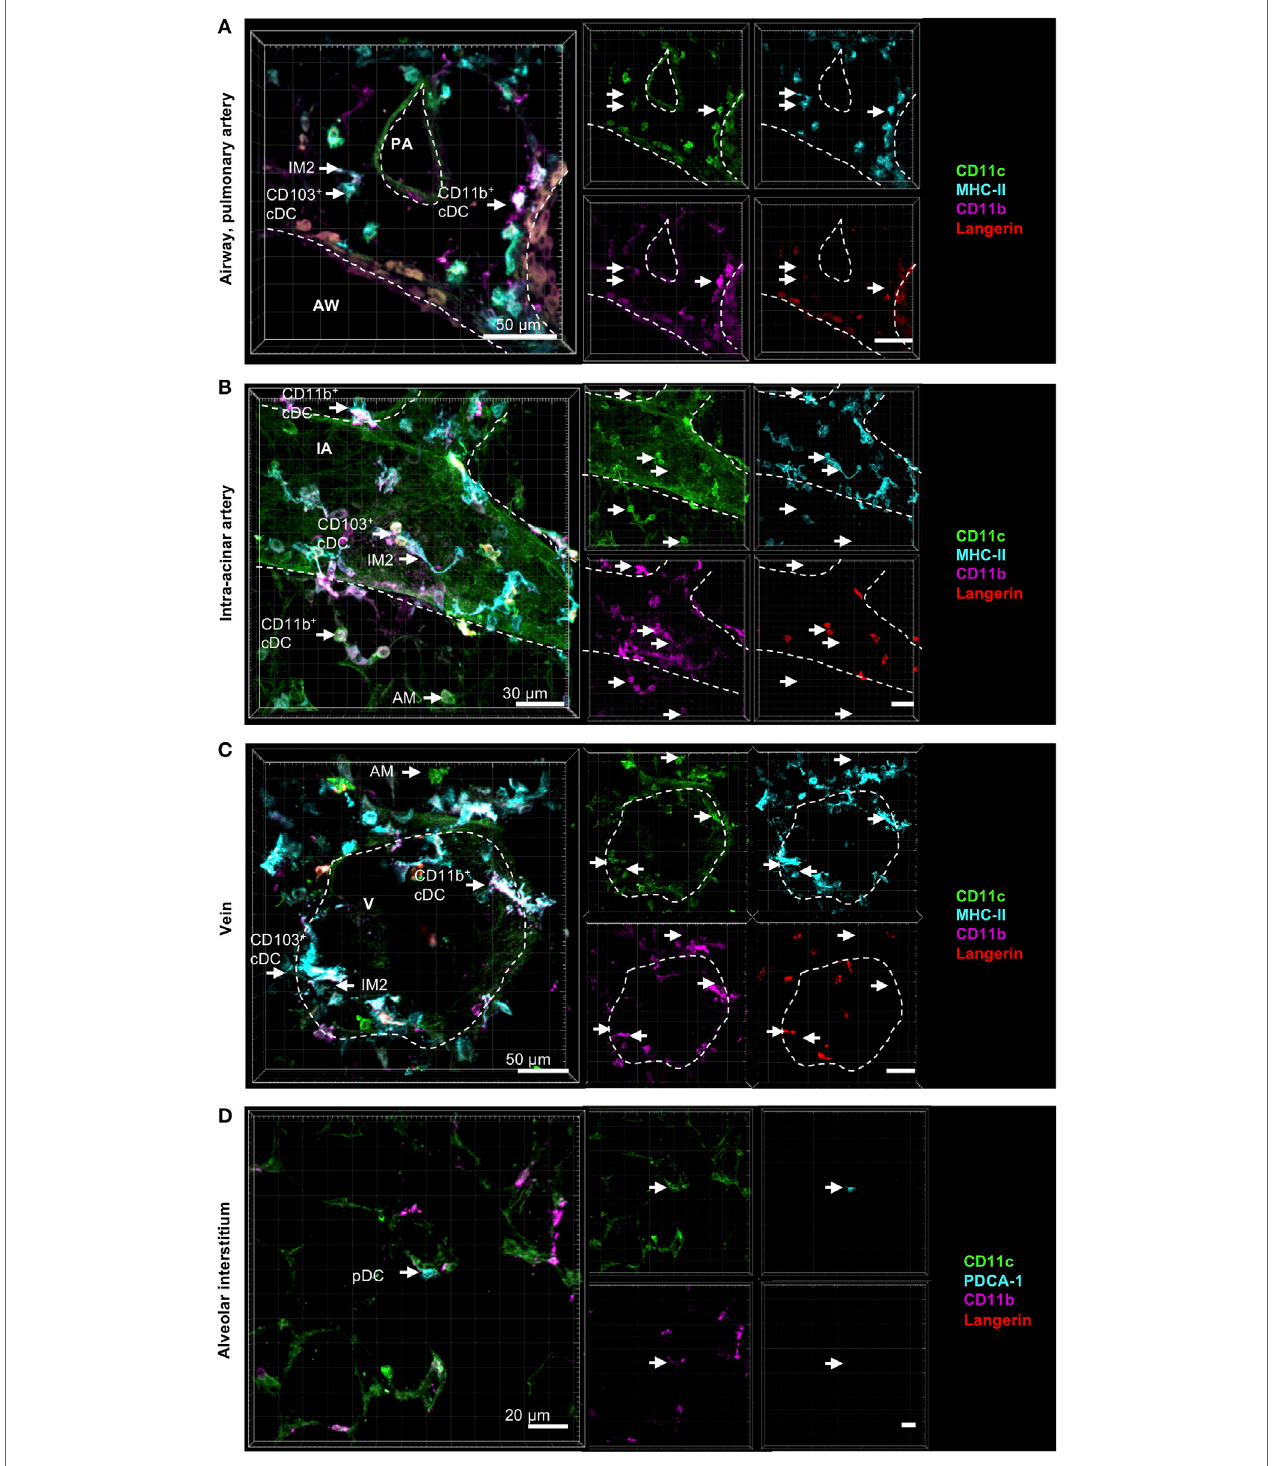
FigUre 3 | Localization of pulmonary dendritic cell (DC) and macrophage subsets by immunohistochemistry (IHC). Precision cut lung slices (PCLS) (300 µm) from naive C57BL/6 mice were generated and stained with anti-CD11c (green), anti-MHC-II or mPDCA-1 (turquois), anti-CD11b (purple), and anti-Langerin (red) ABs. Stained slices were evaluated with confocal microscopy. Conventional DCs (cDCs) and interstitial macrophages (IMs) were localized in the interstitium around AWs and pulmonary arteries (a) , around IAs (B) , and Vs (c) , while alveolar macrophages (AMs) were only located in the alveolar lumen (a–c) . Plasmacytoid DCs (pDCs) were primarily located in the alveolar interstitium (D) . Dashed lines indicate AWs and/or vessels. Abbreviations: AW, airway; PA, pulmonary artery; V, vein; IA, intra-acinar artery. Data are representative of at least three independent